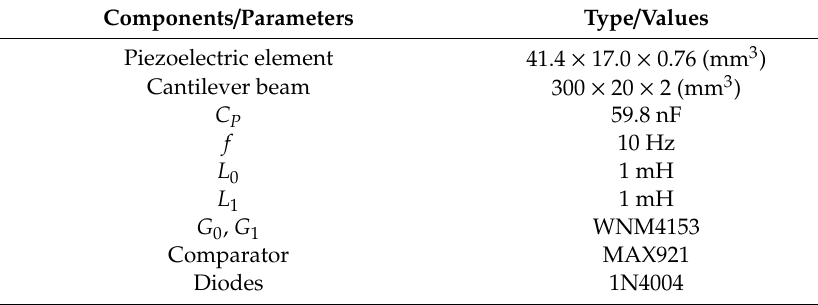
Table 1. Parameters of the experimental system.